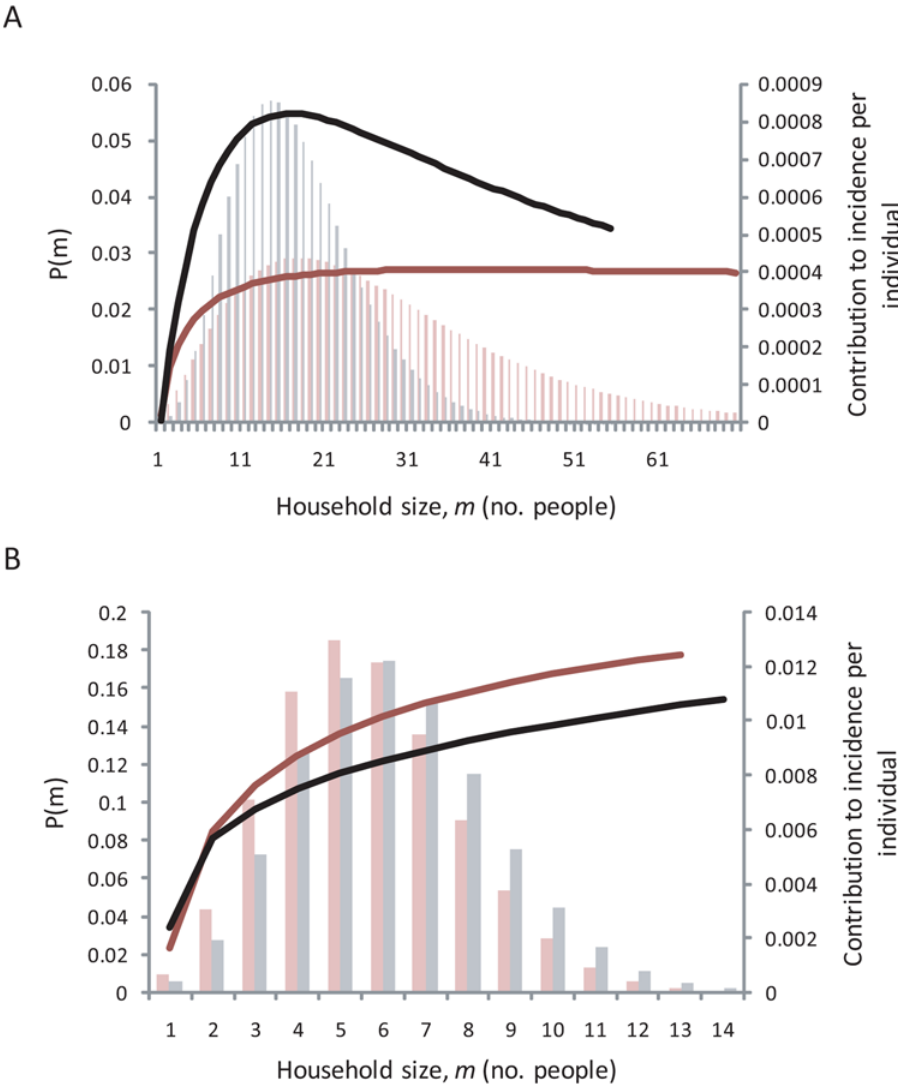
Figure 1. Proportion of incidence contributed per individual from a household of size m (solid line) and the probability distribution of a randomly chosen individual belonging to a household of that size, P(m), based on the negative binomial distribution in (A) The Gambia – the black lines correspond to Upper Saloum district and the red lines correspond to Jali village; and (B) Tanzania – the black lines correspond to Kahe Mpya sub-village and the red lines correspond to Maindi